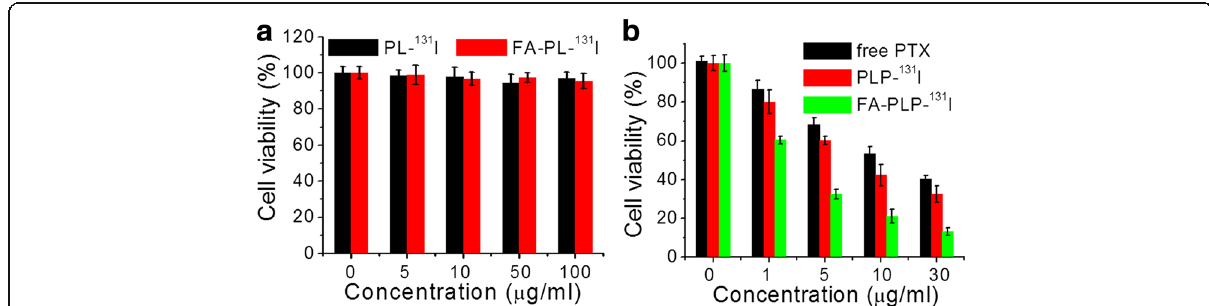
Fig. 5 a Cell viability of B16F10 cells after treatment with PL- 131 I and FA-PL- 131 I for 24 h. b Cell viabilities of B16F10 cells after incubation with different concentrations of free PTX, PLP- 131 I, and FA-PLP- 131 I for 24